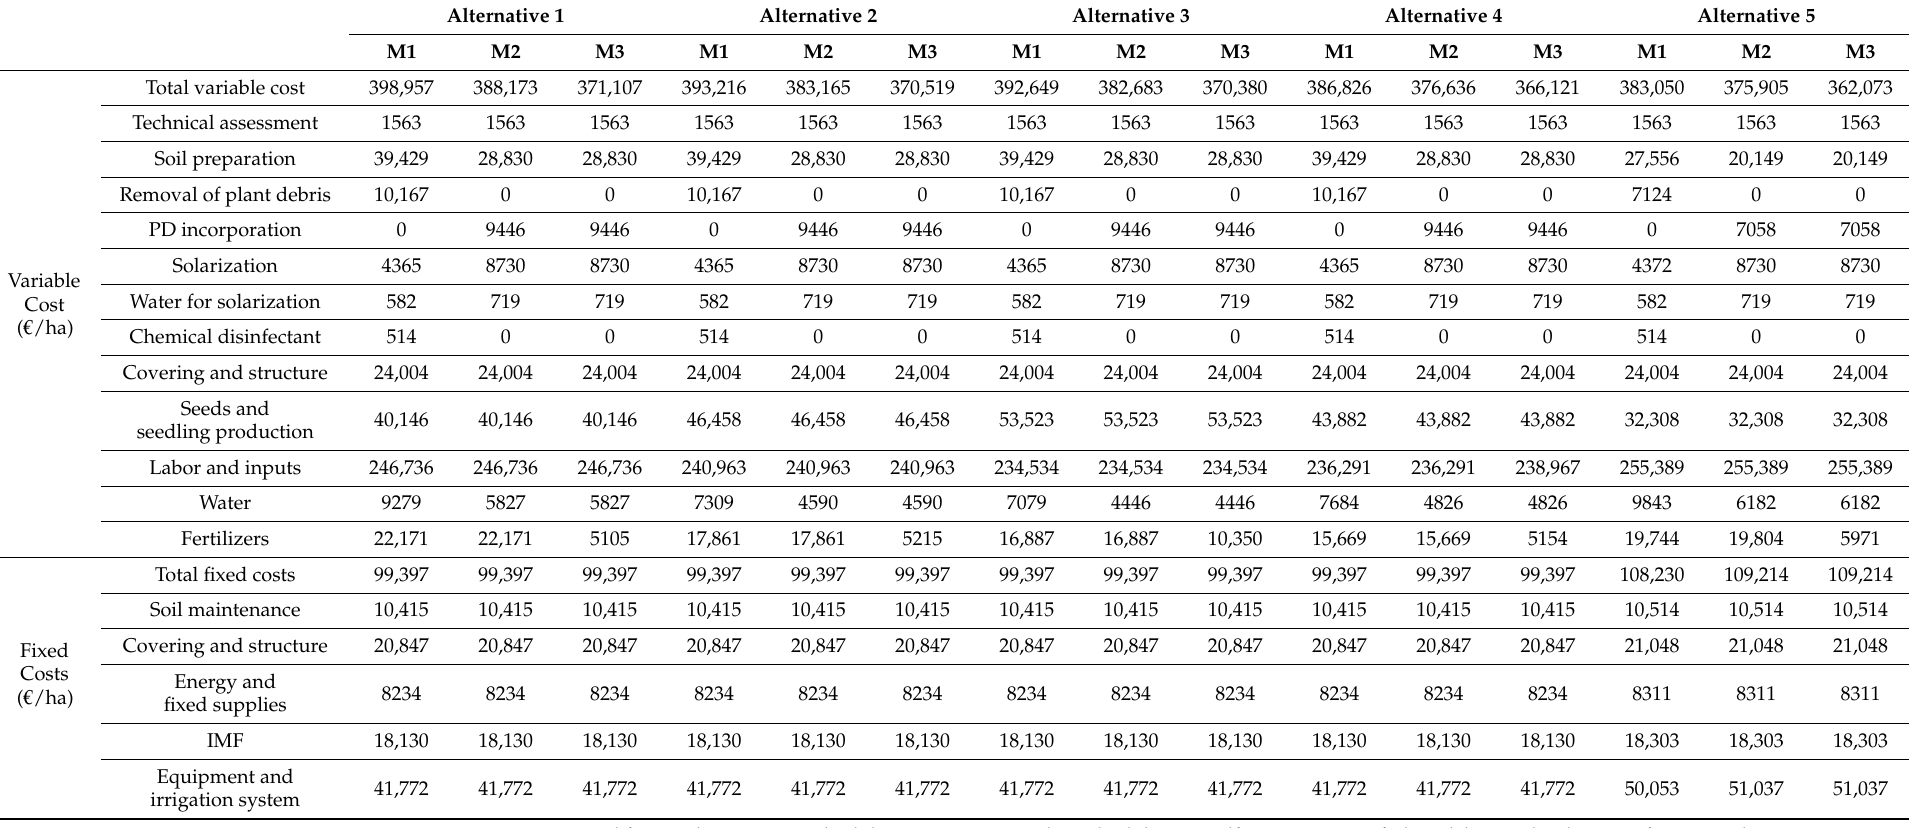
Table A2. Comparison of the cost structure of five horticultural alternatives under three production methodologies from February 2016 to June